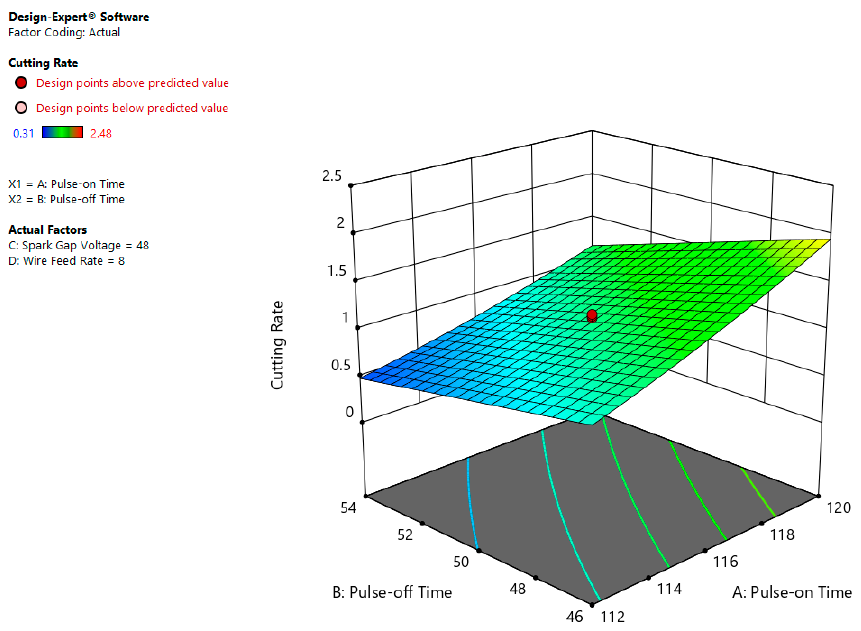
Figure 6. Interactive effect of pulse-on time (Ton) and pulse-off time (Toff) on CR.